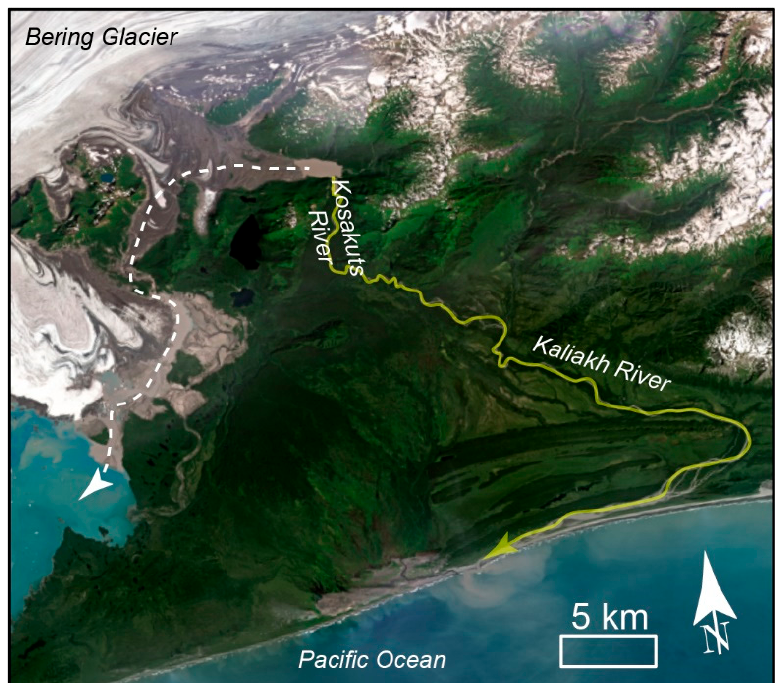
Figure 3. Satellite image showing a possible change in drainage at the southeast side of Bering Glacier. Yellow line shows the current drainage route; dashed white line indicates the possible future drainage path described in the text. Background image is a July 2021 satellite mosaic from Planet, and projection is Alaska Albers Equal Area Conic.